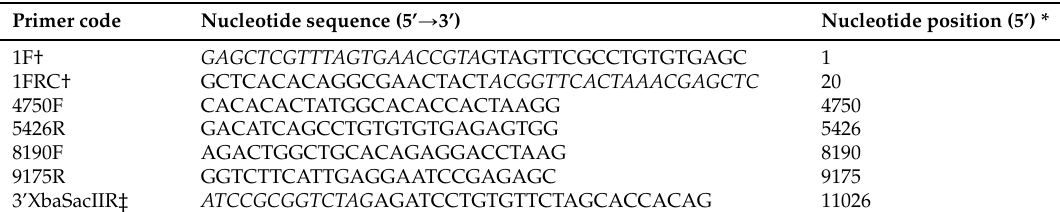
Table 1. List of primers used to generate overlapping fragments of the West Nile virus (WNV) genome in order to construct the full-length clone